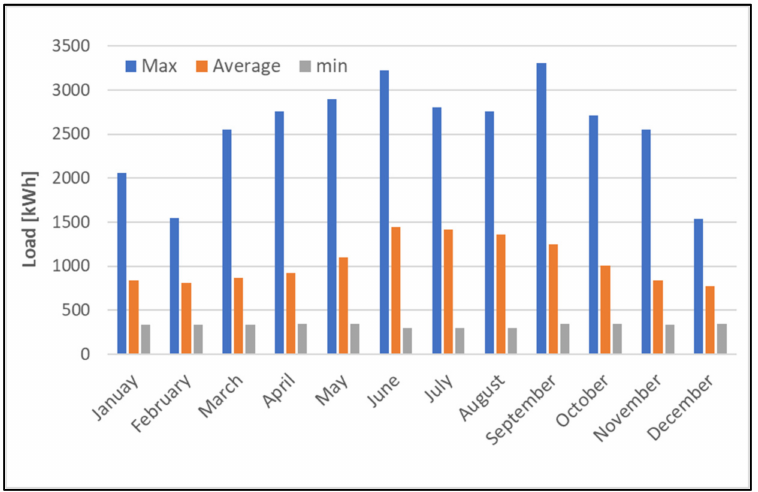
Figure 22. Monthly average electricity consumption in Chikushi campus, Kyushu University,